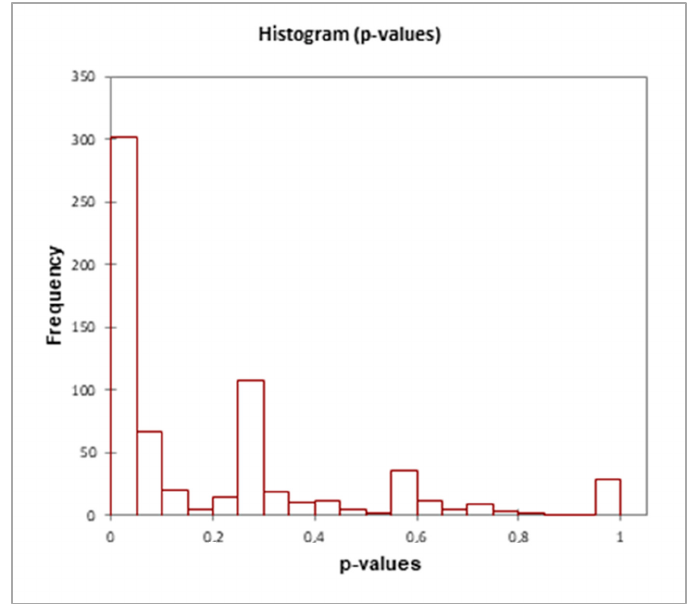
Figure 8. Distribution histograms of differentially expressed proteins in A. maxima samples treated with glyphosate compared to control cultivations in the range of p -values. XLSTAT 2021.3.1.1187—Differential expression feature. The details of the analysis are shown in Supplementary Tables S2 and S3.